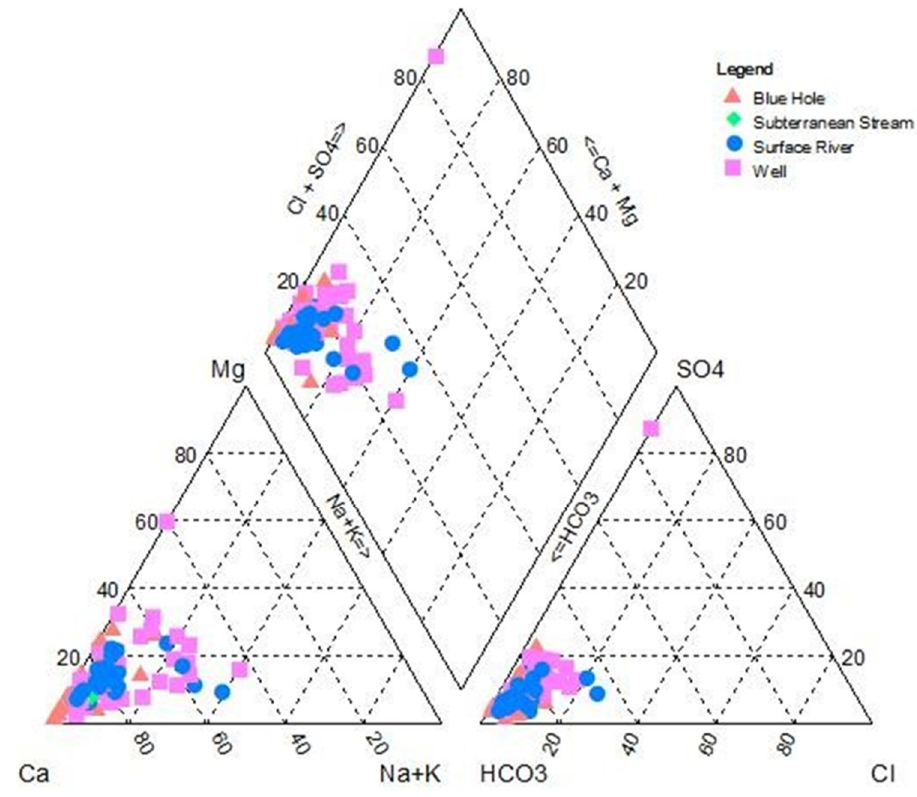
Figure 3. Durov diagram of ionic concentrations of different samples of the Huixian karst